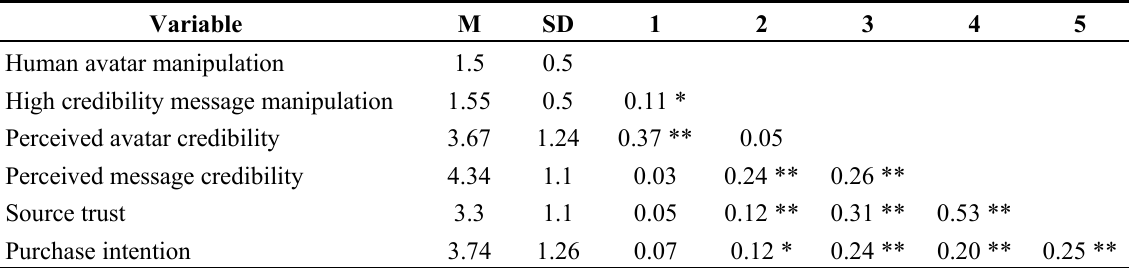
Table 1. Correlation matrix of path